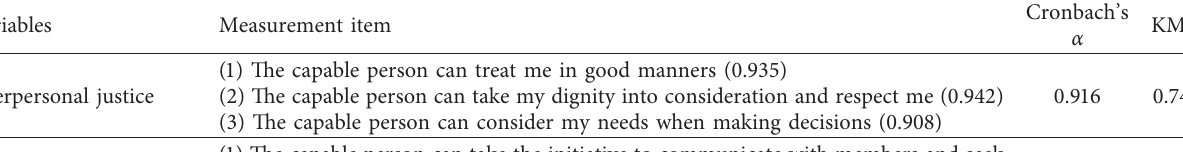
Table 3: Reliability and validity of each variable.